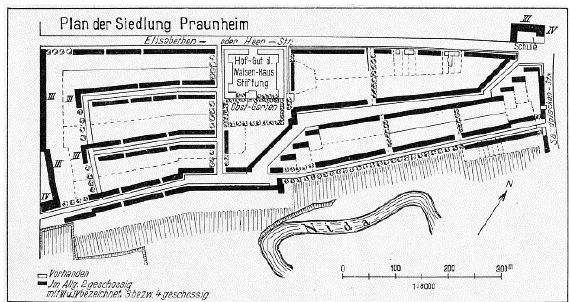
Figure 10. Praunheim I-II. Source: Schürmeyer